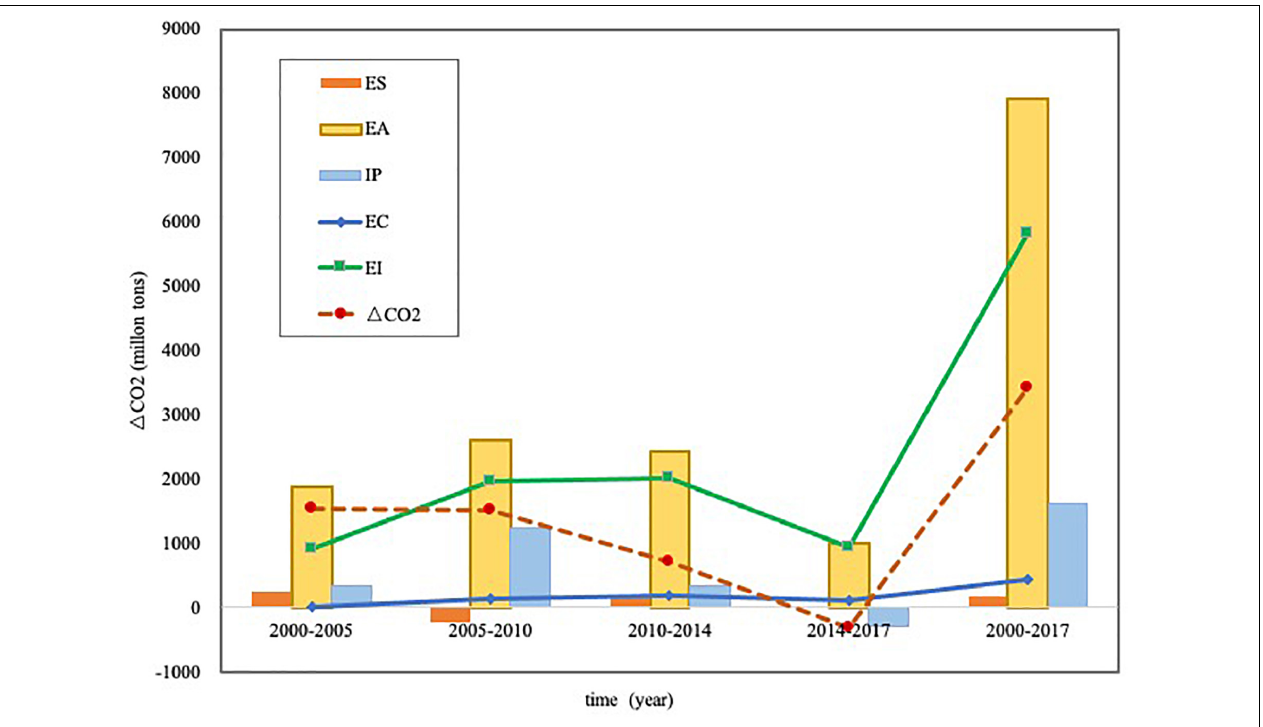
FIGURE 2 | Decomposition result of carbon emission changes in manufacturing